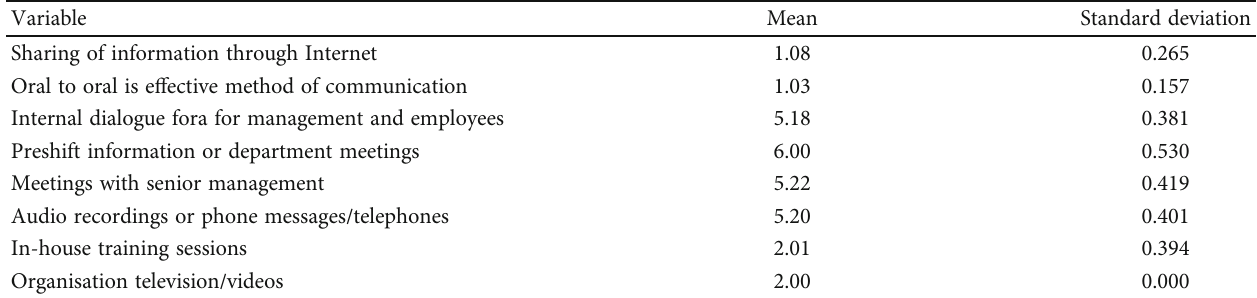
Table 2: Channels of communication employed in the organisation to motivate